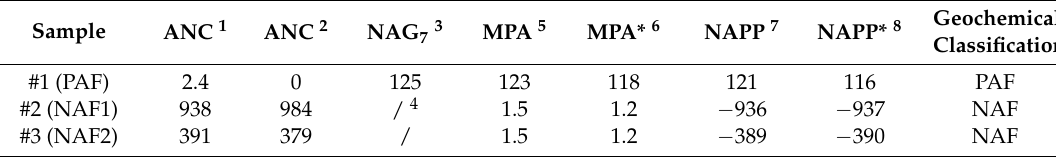
Table 3. Net acid generation and acid base accounting results for samples for the case study (units in kg · H 2 SO 4 · t − 1 unless stated otherwise).